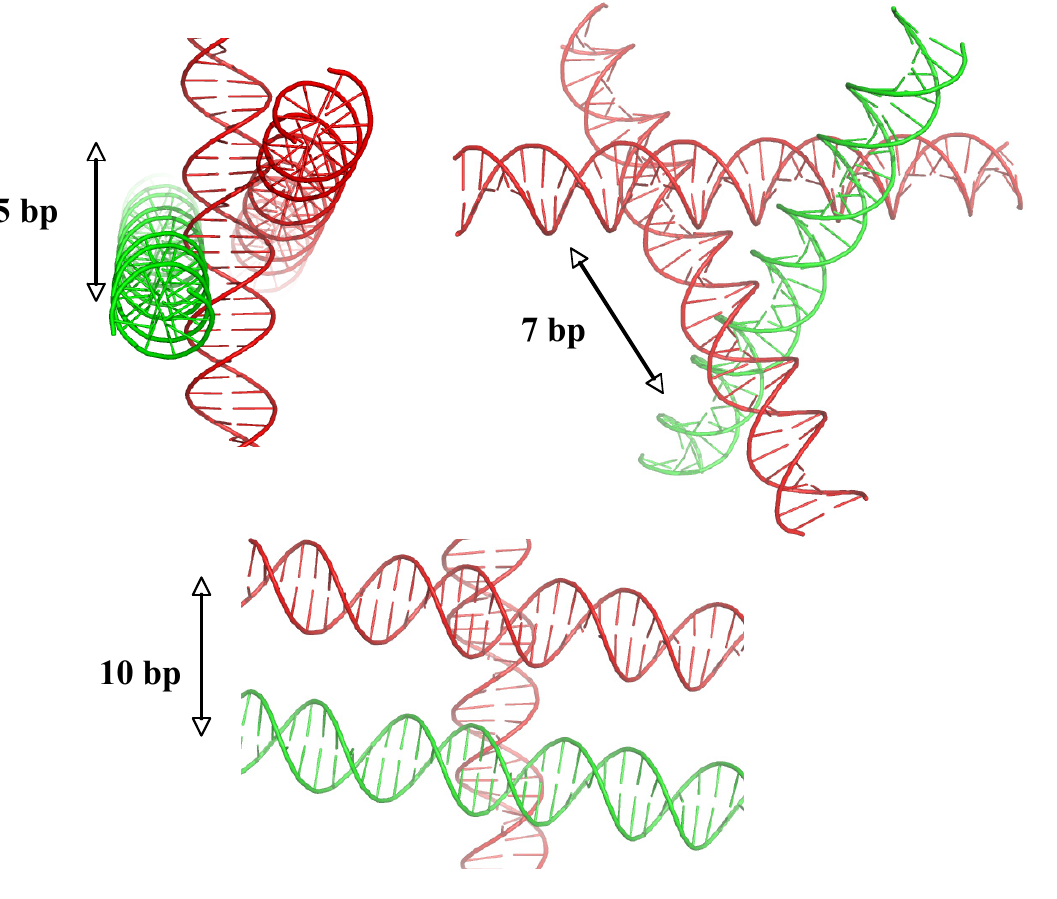
Figure 4. DNA supramolecular construction set. The double helix imposes discrete geometric solutions for its 3D assembly into simple motifs. Representation of packing motifs formed by two helices crossing a third one, at anchoring points separated by 5 bp, 7 bp and 10 bp, respectively. An equilateral triangle is formed when the intersection points of three DNA segments are 7 bp